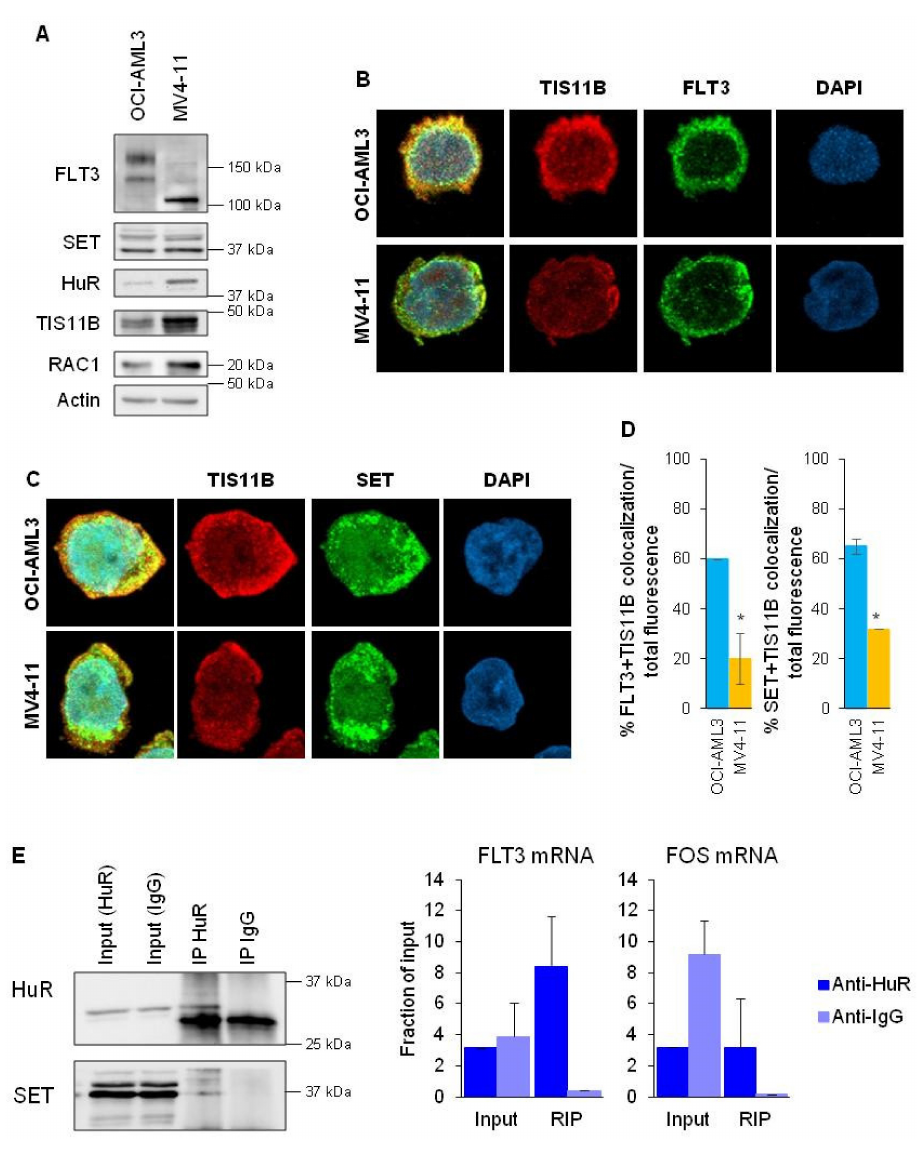
Figure 2. FLT3, TIS11B, HuR and SET form a complex in FLT3-WT cells. ( A ) Western blot analysis of OCI-AML3 (FLT3-WT) and MV4-11 (FLT3-ITD) for FLT3, SET, HuR, TIS11B, RAC1, and normalized with β -Actin, indicating expression of those proteins in both cell lines. Representative WBs are shown. ( B ) Immunofluorescence of FLT3 (green) and TIS11B (red) in AML cell lines OCI-AML3 (FLT3- WT) and MV4-11 (FLT3-ITD). The confocal microscopy pictures showed co-localization (yellow) of both proteins in FLT3-WT cells and hardly in FLT3-ITD cells. Nuclei are stained with DAPI (blue). ( C ) Immunofluorescence of SET (green) and TIS11B (red) in AML cell lines OCI-AML3 (FLT3-WT) and MV4-11 (FLT3-ITD). Confocal microscopy showed co-localization (yellow) of both proteins in FLT3-WT cells and hardly in FLT3-ITD cells. Nuclei are stained with DAPI (blue). ( D ) Co-localization analysis of FLT3 and TIS11B and SET and TIS11B in OCI-AML3 and MV4-11. Mean values ± SEM are represented. ( E ) RNA-immunoprecipitation in OCI-AML3 cells. Protein–RNA complexes were pulled down with anti-HuR antibody, and FLT3 abundance was normalized to HPRT and is shown as a fraction of input. Left, analysis by western blot of immunoprecipitated lysates, showing immunoprecipitation of HuR along with co-immunoprecipitation of SET. Right, RT-qPCR analysis of FLT3 mRNA immunoprecipi- tated along with the positive control FOS. * p < 0.05 FLT3-ITD cells vs. FLT3-WT cells. Protein–RNA complexes were pulled down with anti-HuR antibody, and GFP abundance was normalized to HPRT and is shown as a fraction of input. The uncropped bolts are shown in Supplementary Materials File